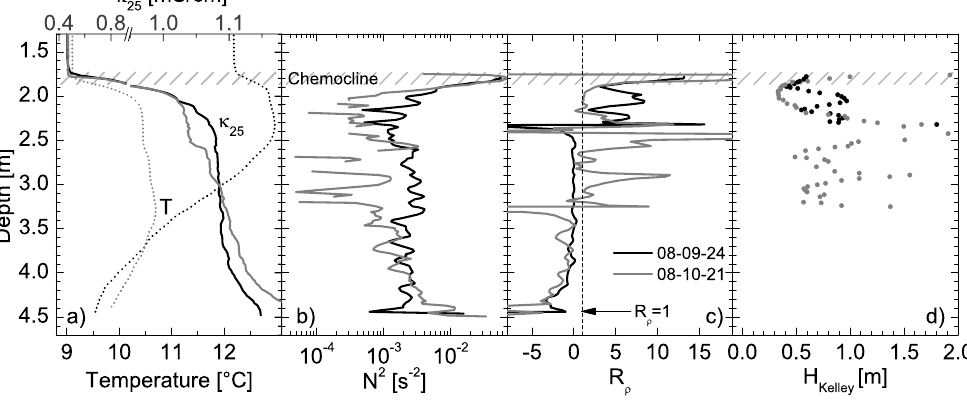
Fig. 4. (a) profiles of Temperatures and electrical conductivity at 25 ◦ C, (b) Local stability N 2 , (c) stability ratio R ρ , and (d) calculated size of potential double diffusive steps in a situation before (24 September 2008) and after (21 October 2008) the onset of convection in the monimolimnion of Lake Waldsee (a).